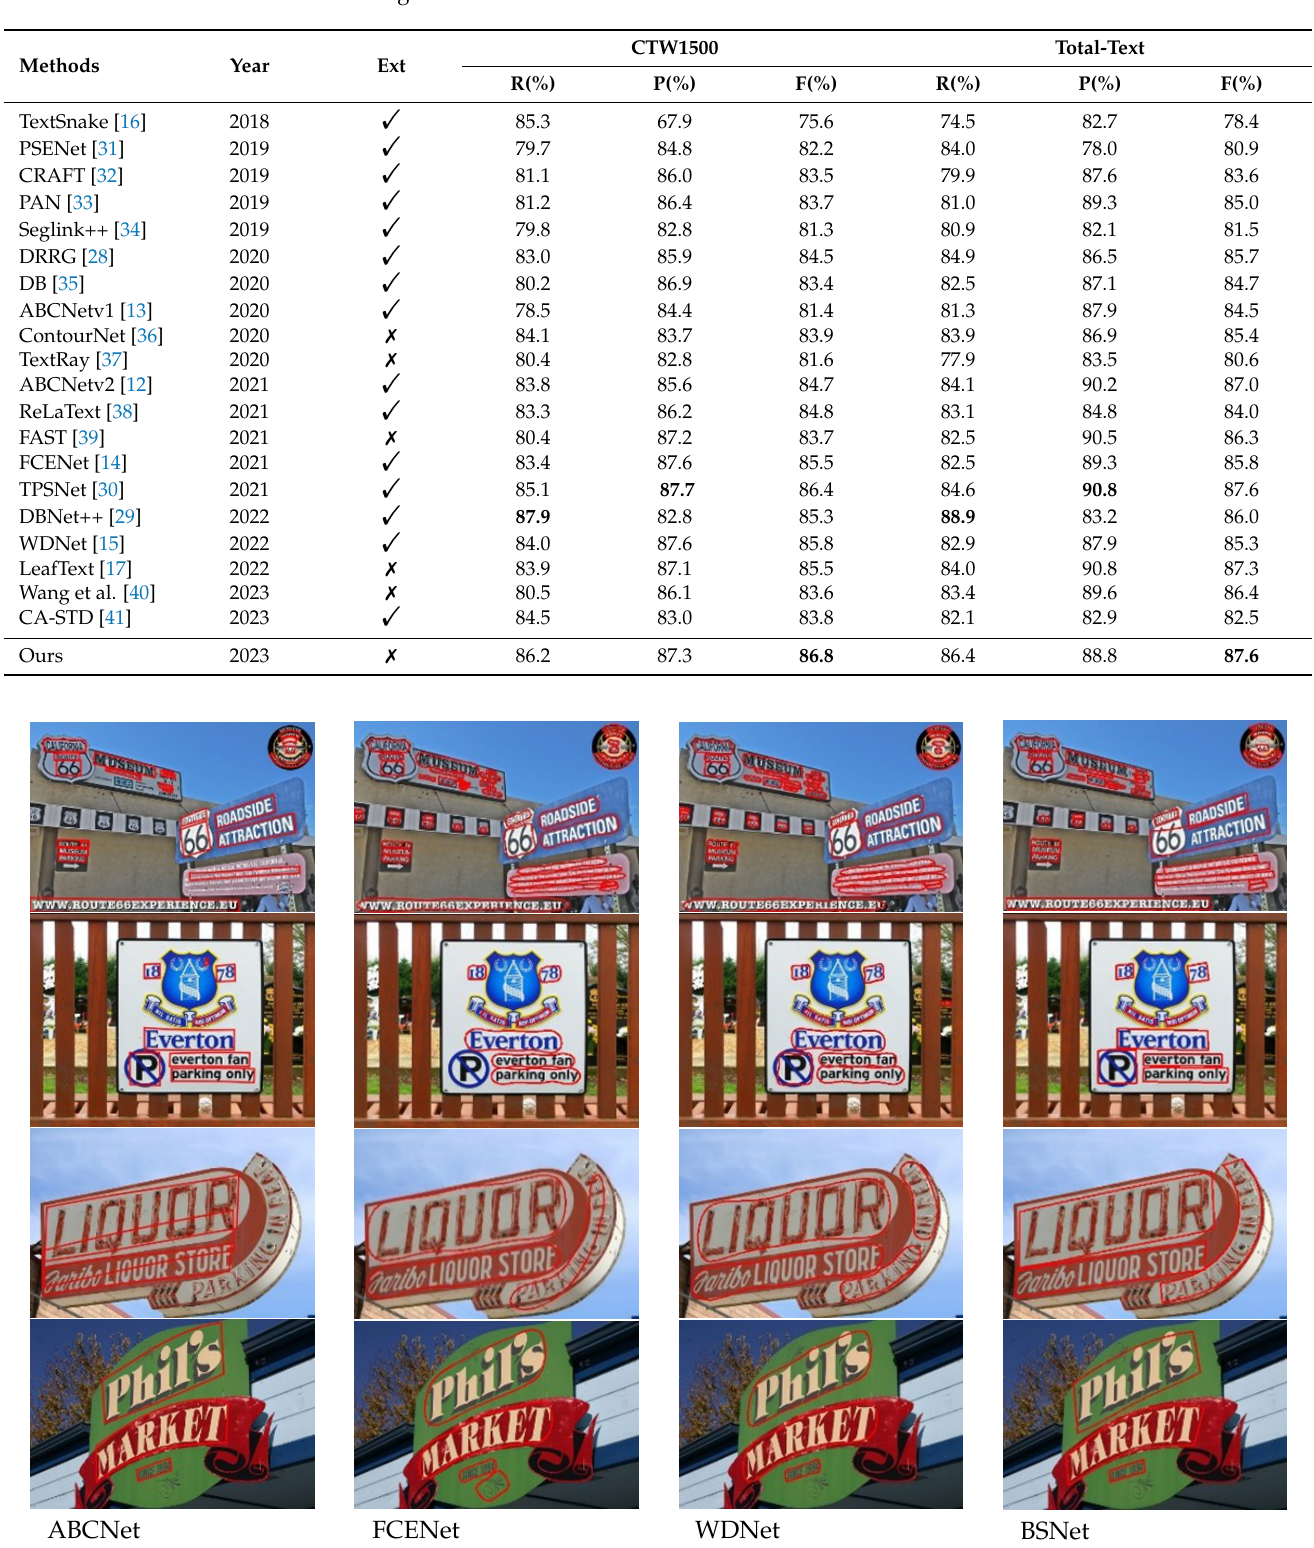
Table 4. Comparison with previous methods on CTW1500, Total-Text, and ICDAR2015, Ext: extra training data.